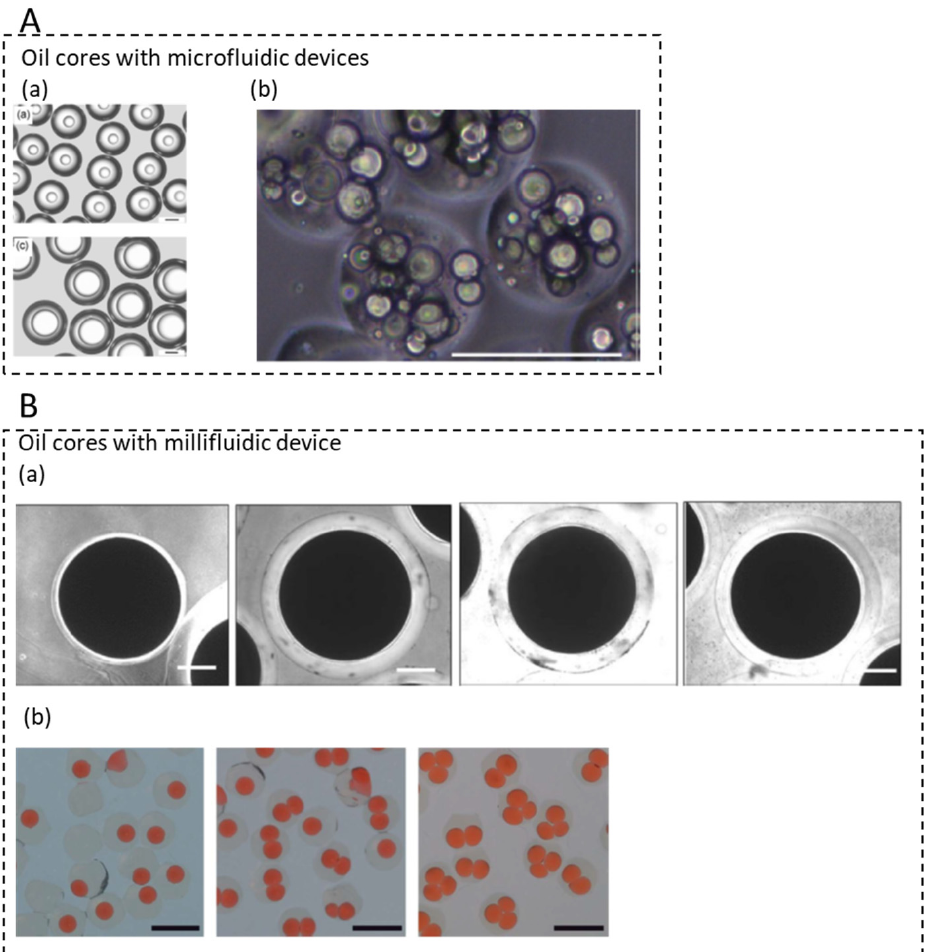
Figure 5. Oil core/aqueous shell microcapsules. ( A ) Microcapsules by droplet microfluidics: ( a ) Control of the alginate membrane thickness (reprinted from [53], with permission from Elsevier), and ( b ) multiple oil cores by a two-step approach using Pickering emulsion (adapted with permis- sion from [55]. Copyright (2016) American Chemical Society. ( B ) Capsules by droplet millifluidics: ( a ) Control of the alginate membrane thickness of capsules with a diameter of 1 mm and an oil core (reprinted from [57], with permission from Elsevier), and ( b ) control of the number of oil cores in alginate capsules (reproduced from [59], with permission from The Royal Society of Chemistry).